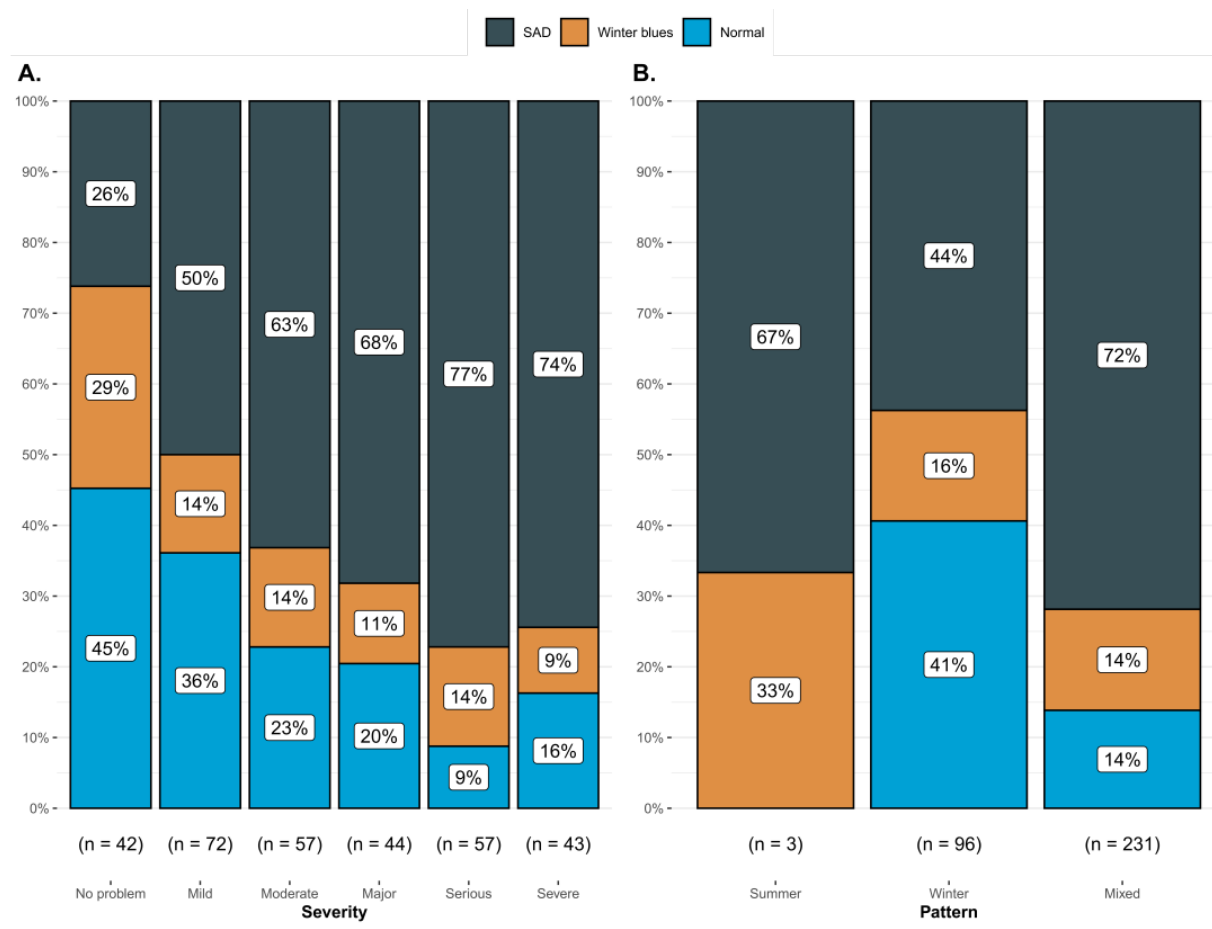
Figure 2. Cumulative bar plots indicating observed proportions between different levels of SSI and ( A ) the severity of self-perceived seasonality, ( B ) and the proportions between the type of seasonal pattern.